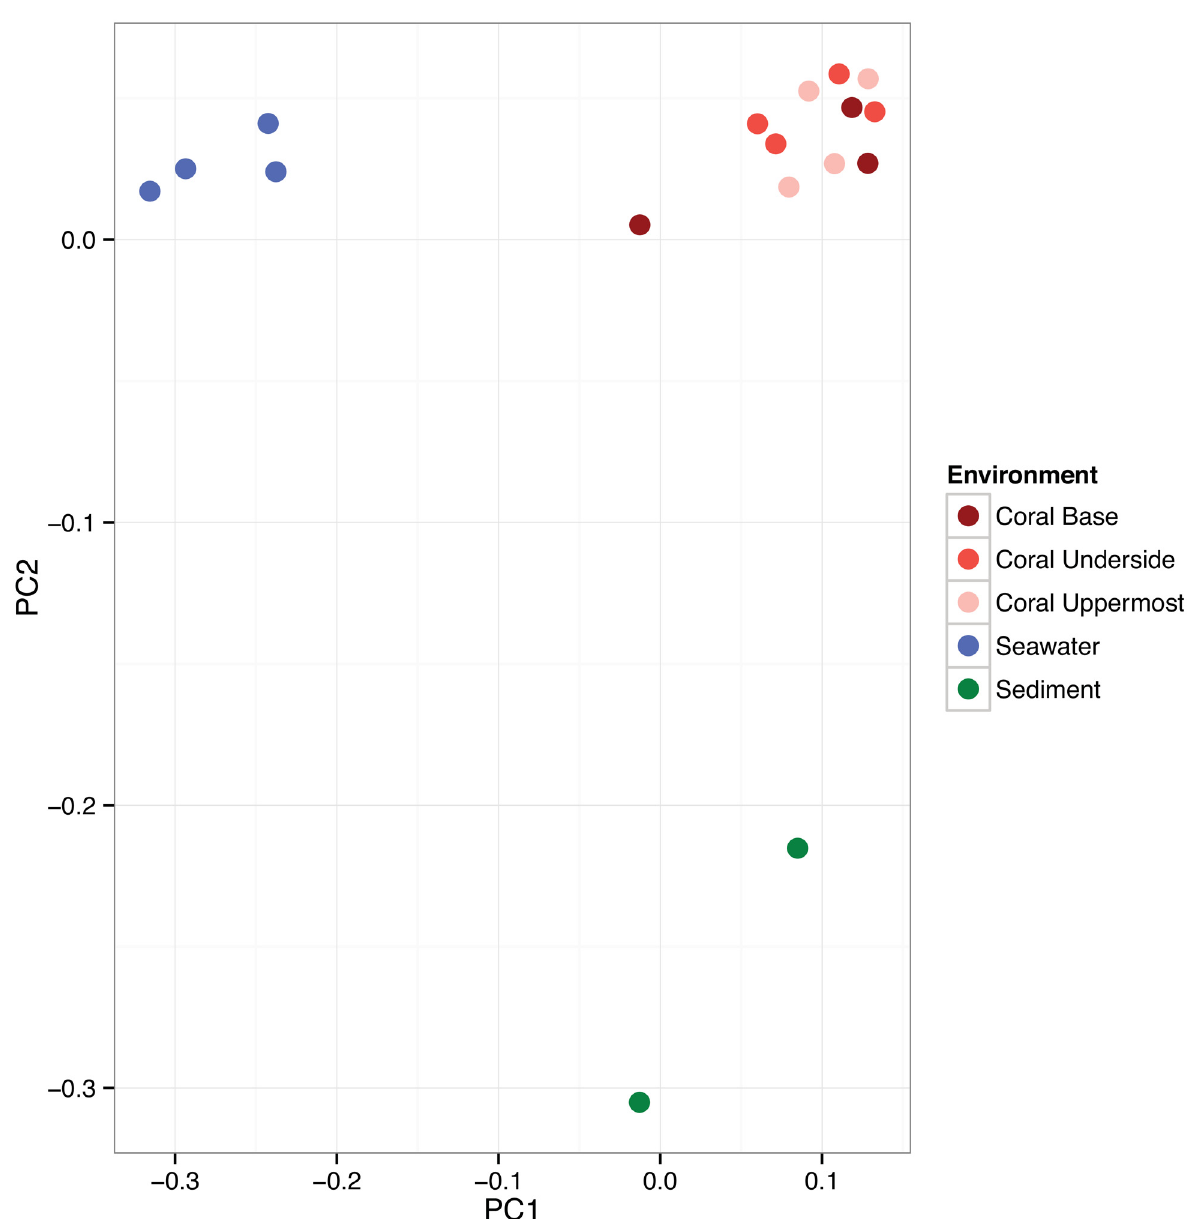
Fig 4. Principal coordinate analysis of beta-diversity metrics among microbial samples from A . palmata . Samples are coded by source tissue or environment (base, underside, uppermost, reef seawater, and